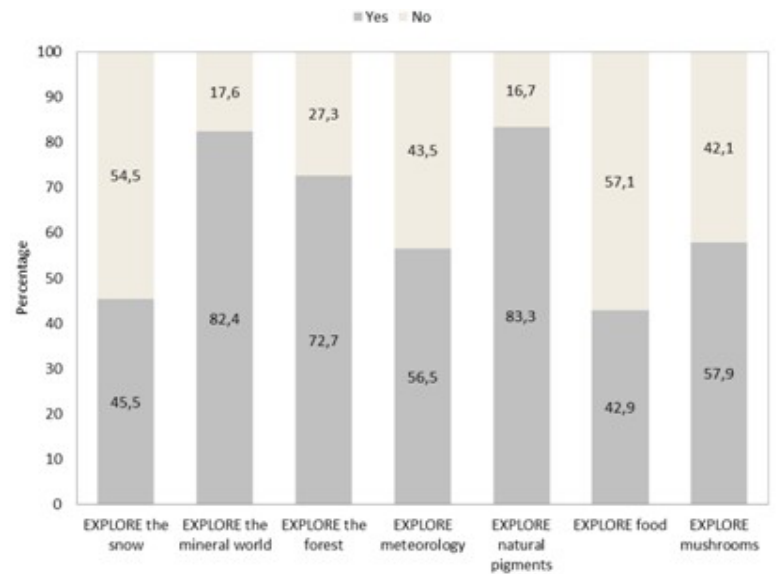
Figure 6. Percentage of responses to the queston: "Will you introduce some